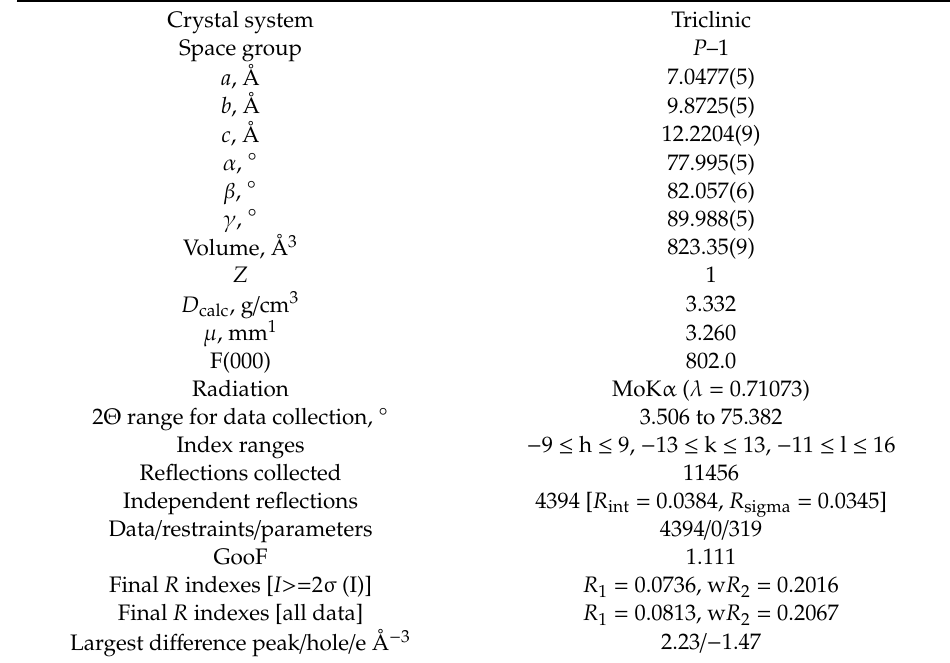
Table 4. Data and structure refinement parameters for chirvinskyite.